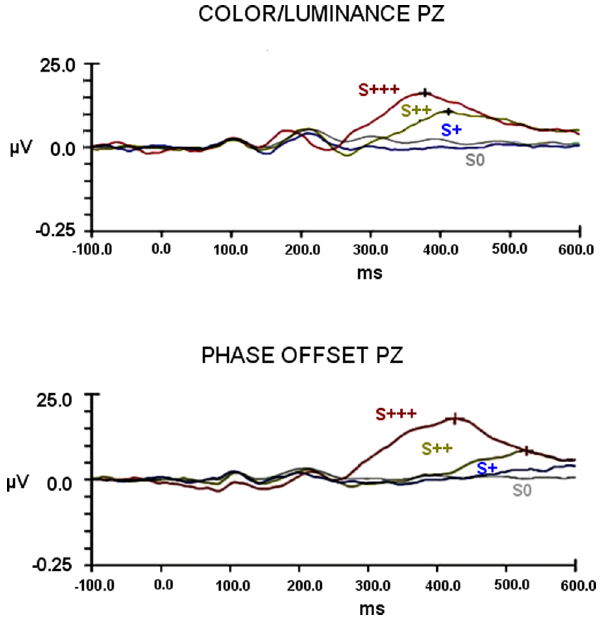
Figure 4. Grand-average ERPs for Experimental Session II (experiments III and IV): Larger and faster responses are confirmed to be present for most salient stimuli. Grand-average ERPs’, time locked for target category level are shown for the PZ electrode. Amplitude in microvolts ( m v) is plotted against time (ms). S0 – ERPs for Standard stimulus; S + ERPs for minimal saliency manipulation (none reaching awareness); S ++ ERPs for intermediate saliency manipulation; S +++ ERPs for the maximal saliency manipulation. Top - ERP average waveforms for Chrominance experiment. Bottom - ERP average waveforms for Luminance experiment. No differences were found between S0 and S + evoked average ERPs which matches behavioral data (Tables S2 and S7 in File S1; and Fig. 2).